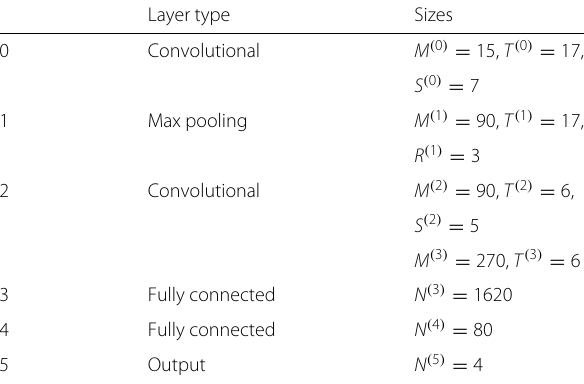
Table 5 Layers of final classifier neural network for ECG dataset